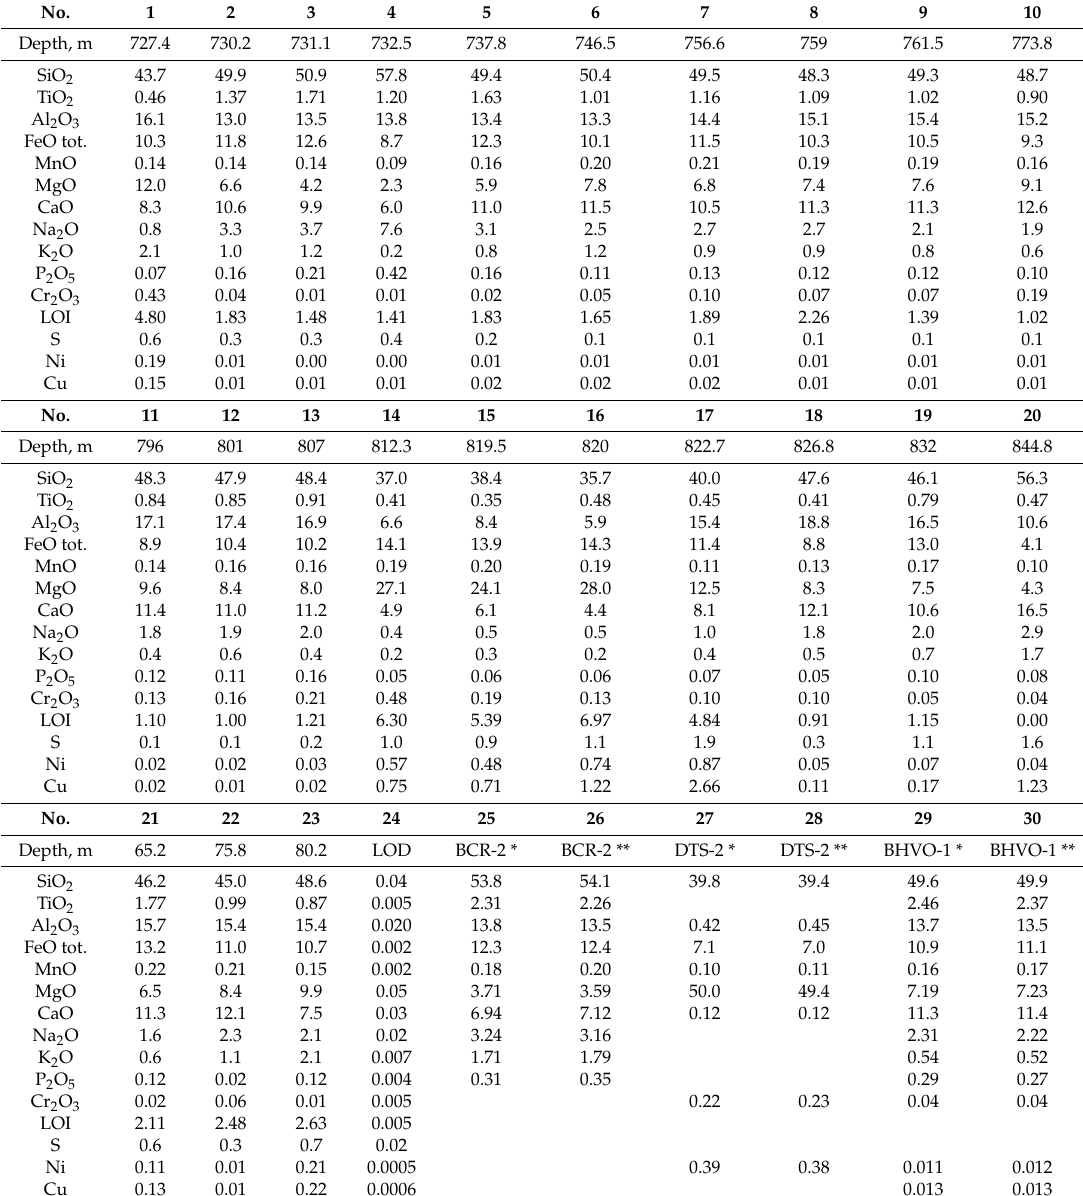
Table 1. Chemical composition of the rocks from the Talnakh intrusion, wt